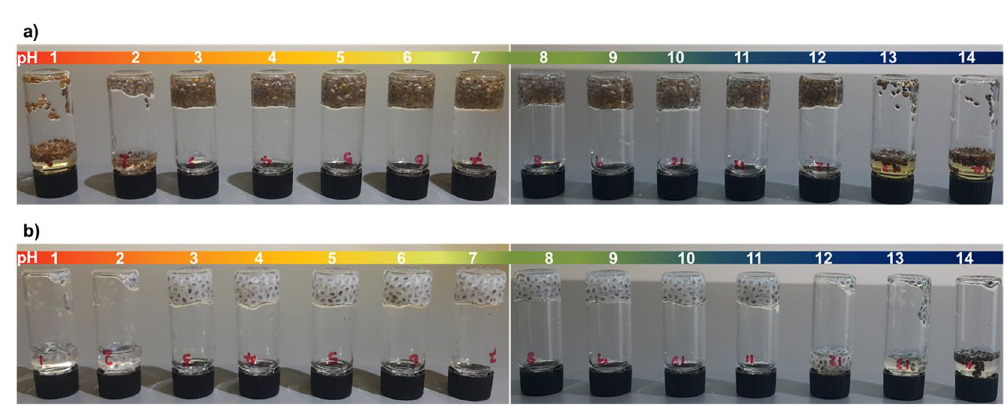
Figure 2. Photographs showing gelation of chia and basil gels in different pH solutions – pH 1 to 14: ( a ) 15% w/v chia seed in respective pH solutions; ( b ) 6% w/v basil seed in respective pH